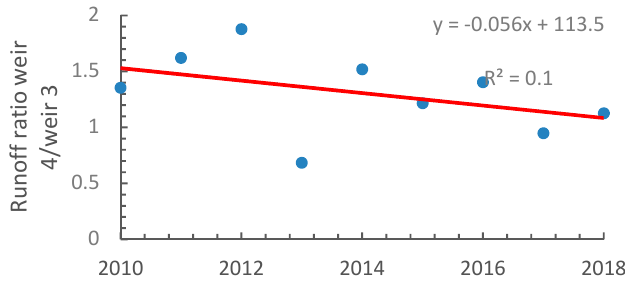
ff ratio of weir 4 / weir 3 over time for the Debre Mawi Figure 8. Runoff ratio of weir 4/weir 3 over time for the Debre Mawi watershed . Figure 8. Runo